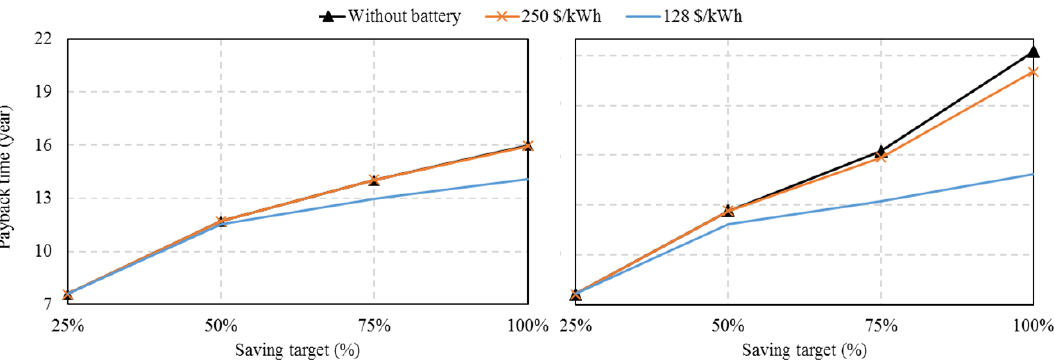
Figure 16. The payback time of the system with and without using a battery of the optimum capacity versus the saving targets for feed-in tariff =6.7 ₵ /kWh ( left ), and 3.35 ₵ /kWh ( right ).